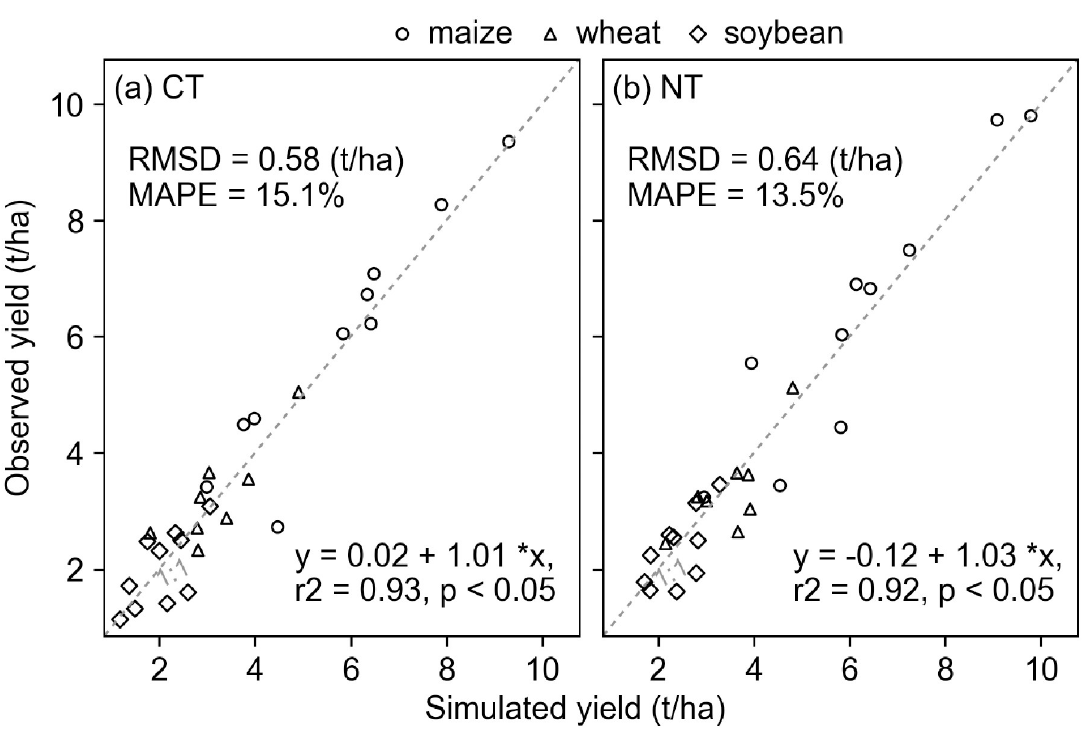
Fig 3. Comparisons between the simulated and the observed grain yield in the maize-soybean-wheat rotation system under (a) conventional (CT) and (b) no-till (NT) treatments at the Kellogg Biological Station in 1989–2016.